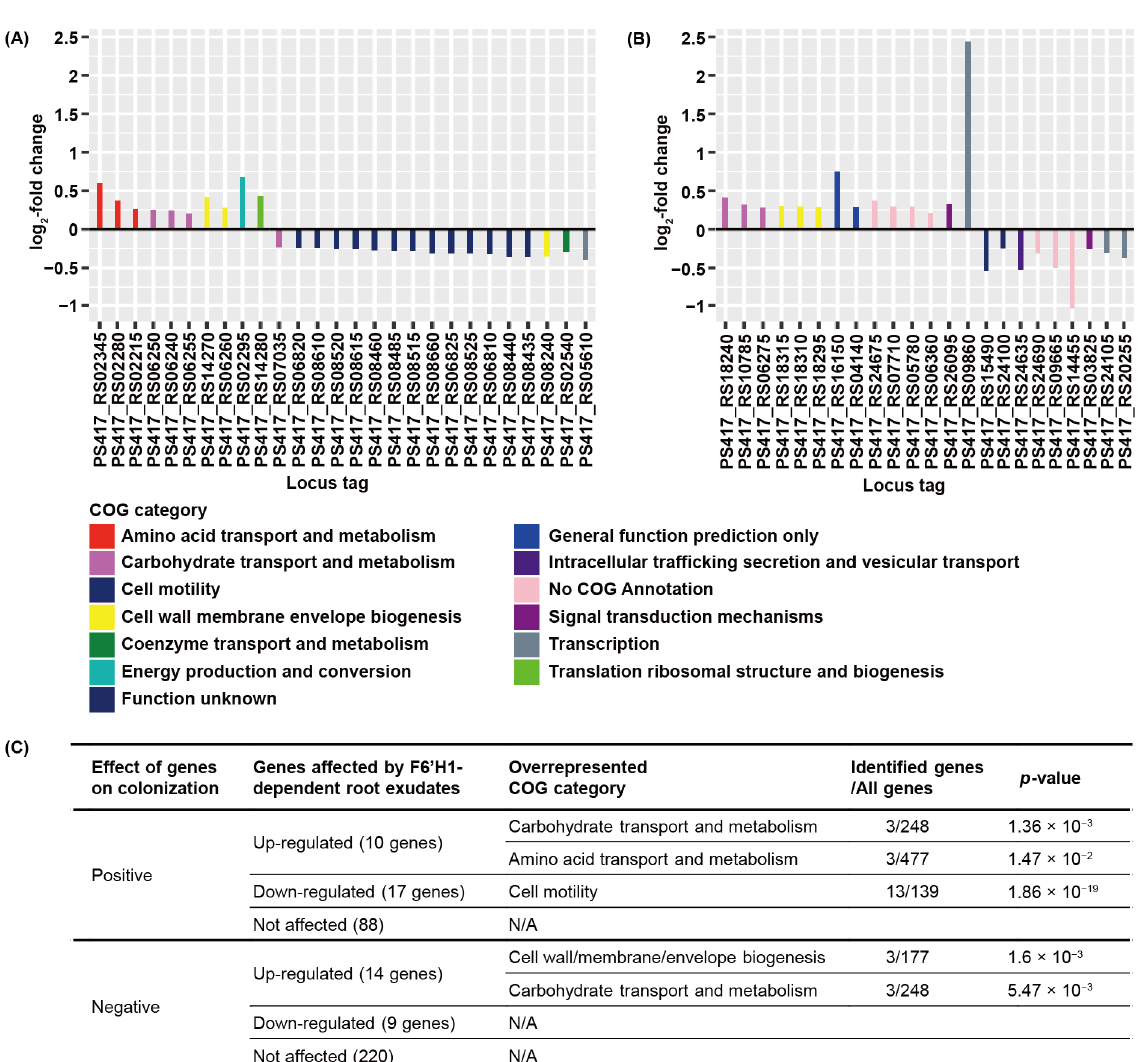
Figure 3. Expression profile of coumarin-responsive WCS417 genes with a previously defined impact on Arabidopsis root colonization. ( A ) Expression profile of coumarin-responsive genes with a positive impact on root colonization (Cole et al., 2017). ( B ) Expression profile of coumarin-responsive genes with a negative impact on colonization (Cole et al., 2017). Positive log 2 -fold change values mean that the genes are up-regulated and negative values mean that the genes are down-regulated by F6 ′ H1-dependent coumarins in the root exudates. Different colors of the bars correspond to different COG categories. ( C ) COG enrichment analysis of selected differentially expressed genes in response to root exudates derived from iron-starved Col-0 and f6 ′ h1 plants. Overrepresented COG categories ( p -value < 0.05) were identified within up- and down-regulated sets of DEGs that had previously been identified to have either a positive or a negative effect on root